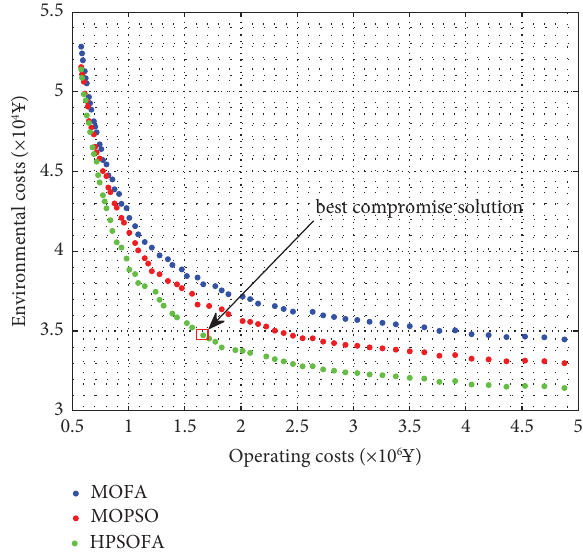
Figure 6: Pareto front in scenario 2.